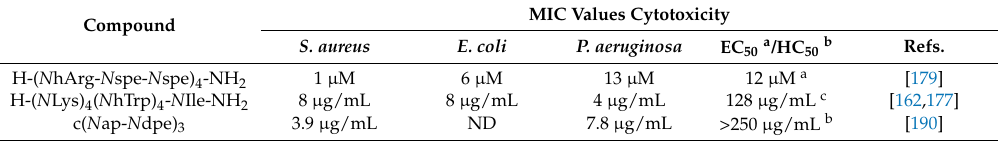
Table 3. Antimicrobial activity and cytotoxicity of representative